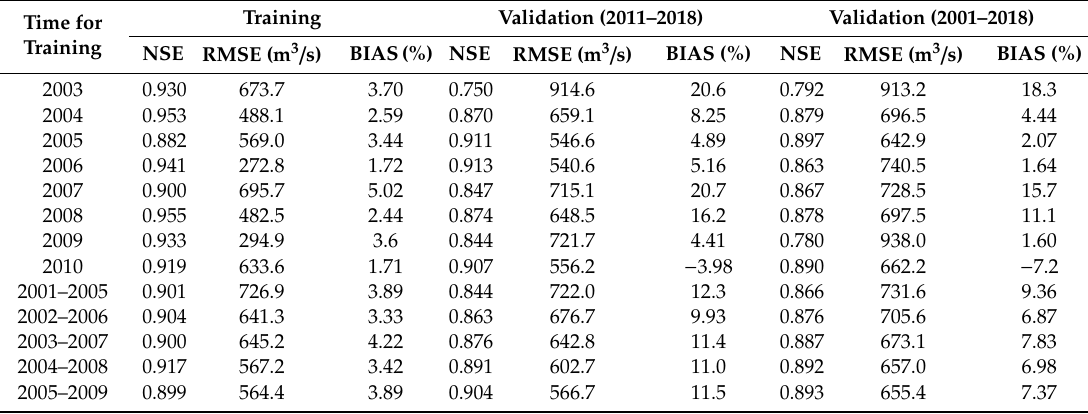
Table 2. Accuracy evaluation of daily discharge estimates using segmented TRMM precipitation data at the Nuxia